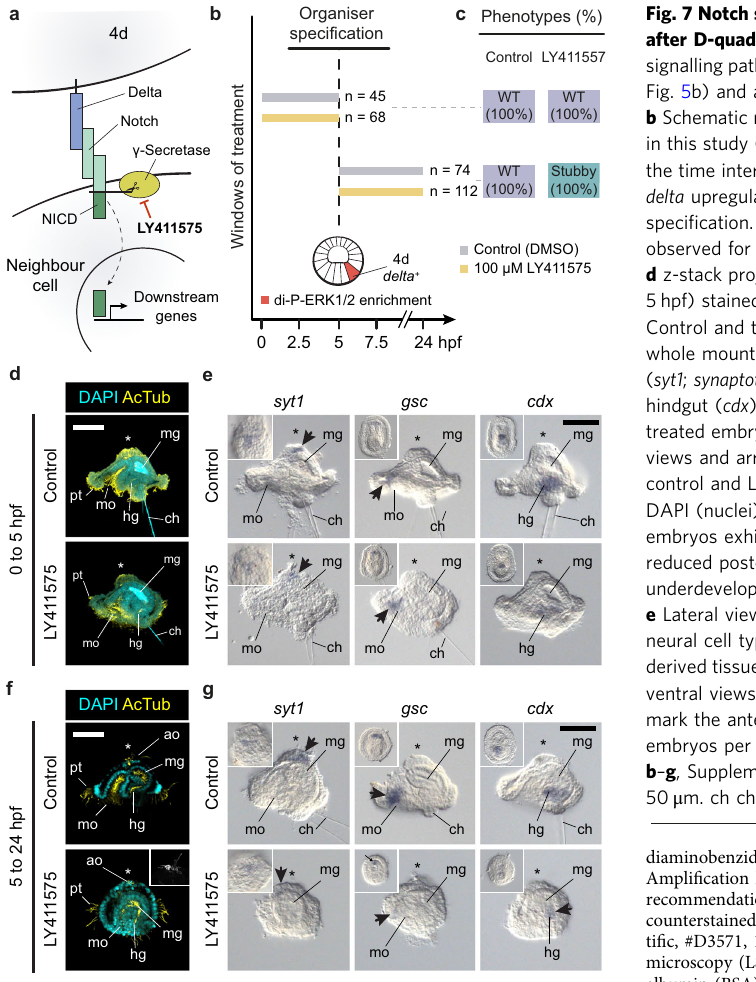
Fig. 7 Notch signalling is required for normal posterodorsal development after D-quadrant speci fi cation. a Schematic drawing of the Notch-Delta signalling pathway, with the Delta ligand being expressed in the 4d cell (see Fig. 5b) and a Notch receptor in its neighbouring cells (Fig. 4d). in this study (number of cases is shown to the right of each bar specifying the time interval). To assess the role of the Notch signalling pathway after delta upregulation in 4d, we treated embryos before and after its speci fi cation. c Distribution and percentages of the larval phenotypes observed for each window and experimental condition (WT, wild